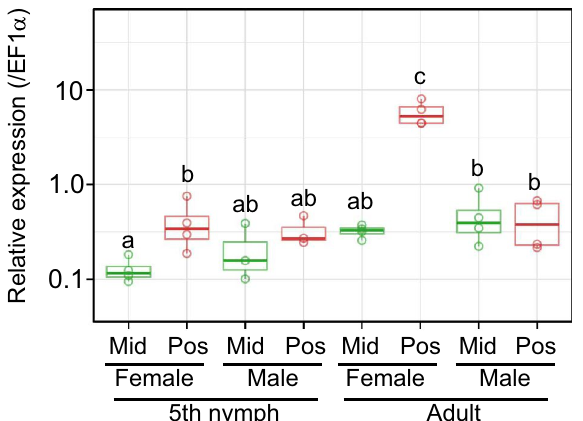
Figure 3. Expression levels of SC mucin gene in the symbiotic midgut. Females and males of fifth instar nymphs and adults were subjected to dissection of the symbiotic midgut, and the middle region (Mid) and the posterior region (Pos) from the samples were individually subjected to RNA extraction and quantitative RT-PCR of the SC mucin gene. Individual quantification values (circles, N = 4) are shown with box plots. Different alphabetical letters indicate statistically significant differences (likelihood ratio test for GLM, P <